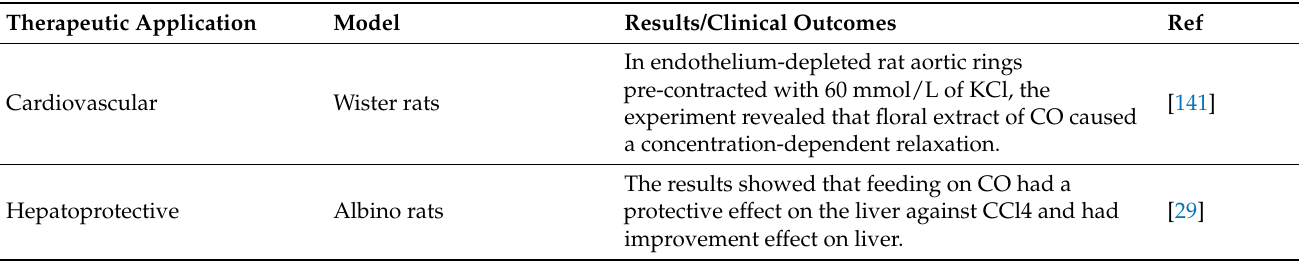
Table 4. Various therapeutic applications of